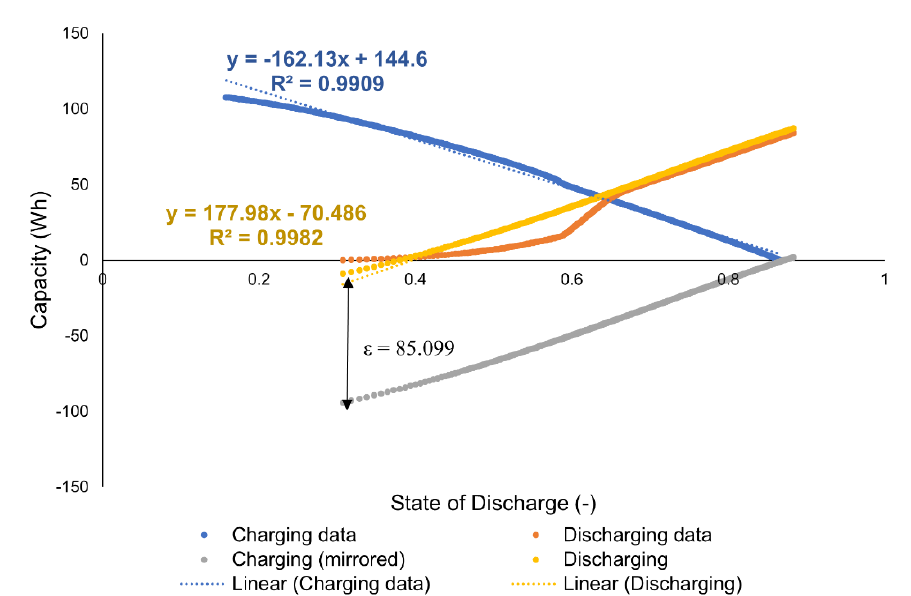
Figure 4. Plot of capacity (Wh) vs. state of discharge of a single NaS cell.